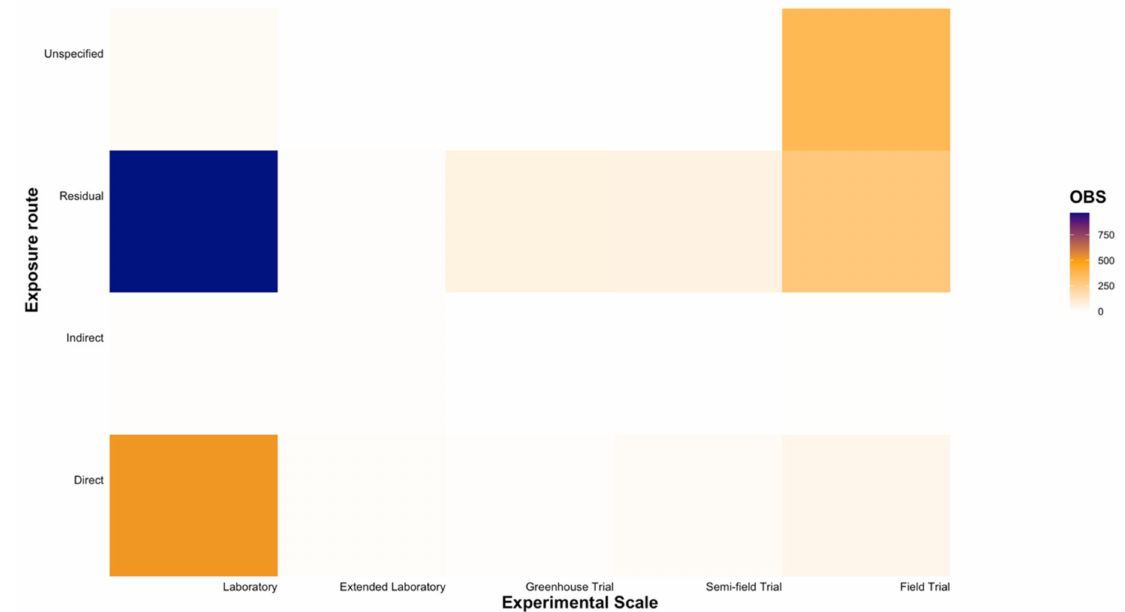
Figure 7. The number of entries (OBS) conducted across five experimental scales (Laboratory, Extended Laboratory, Greenhouse Trial, Semi-field Trial, Field Trial) using different insecticide and miticide exposure routes (Direct, Indirect, Residual, Unspecified) across chemical Modes of Action and natural enemies relevant to the Australian grains